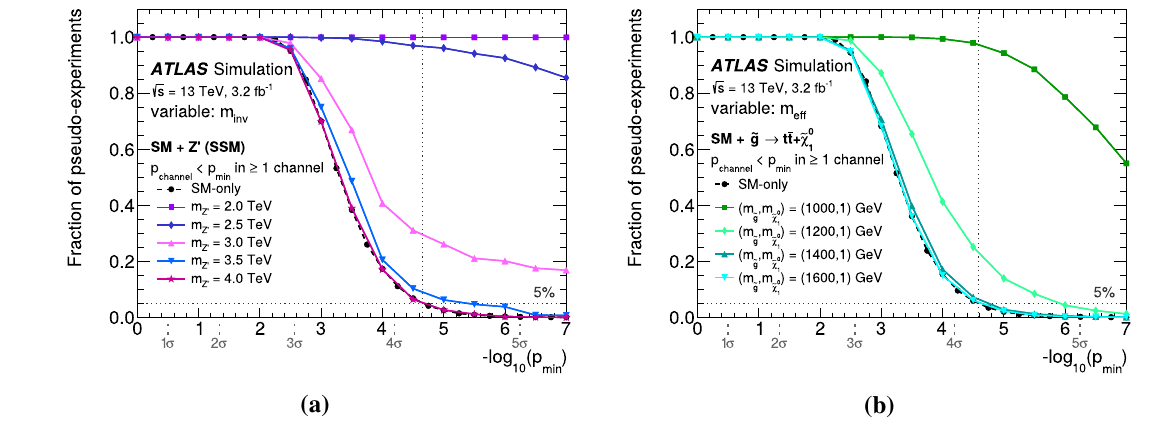
Fig. 8 The fraction of pseudo-experiments in which a deviation is found with a p channel -value smaller than a given p min . Distributions are shown for pseudo-experiments generated from the SM expectation (circular markers), and after injecting signals of a inclusive Z (cid:8) decays